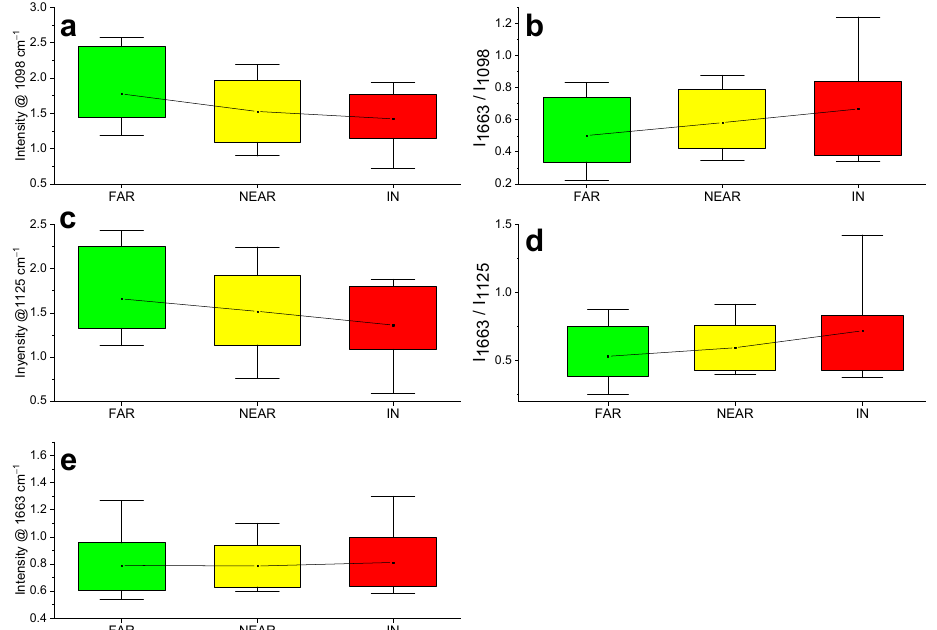
Figure 4. Raman data in terms of 1098 (cellulose, ( a )), 1125 (cellulose, ( c )), 1663 cm − 1 (lignin, ( e )) and lignin/cellulose ratios (1663/1098) ( b ), (1663/1125) ( d ) considering the three main data acquisition location types (“FAR”—green boxplot, “NEAR”—orange boxplot and “IN”—red boxplot locations). The box represents data within the first and the third quartile, the dot symbol represents the mean value and lines extending parallel from the box are the whiskers in the 10–90 range. Table 1. Mean values for the whisker plots shown in Figure 4. ANOVA Raman Frequencies Assignment Datasets Mean Values